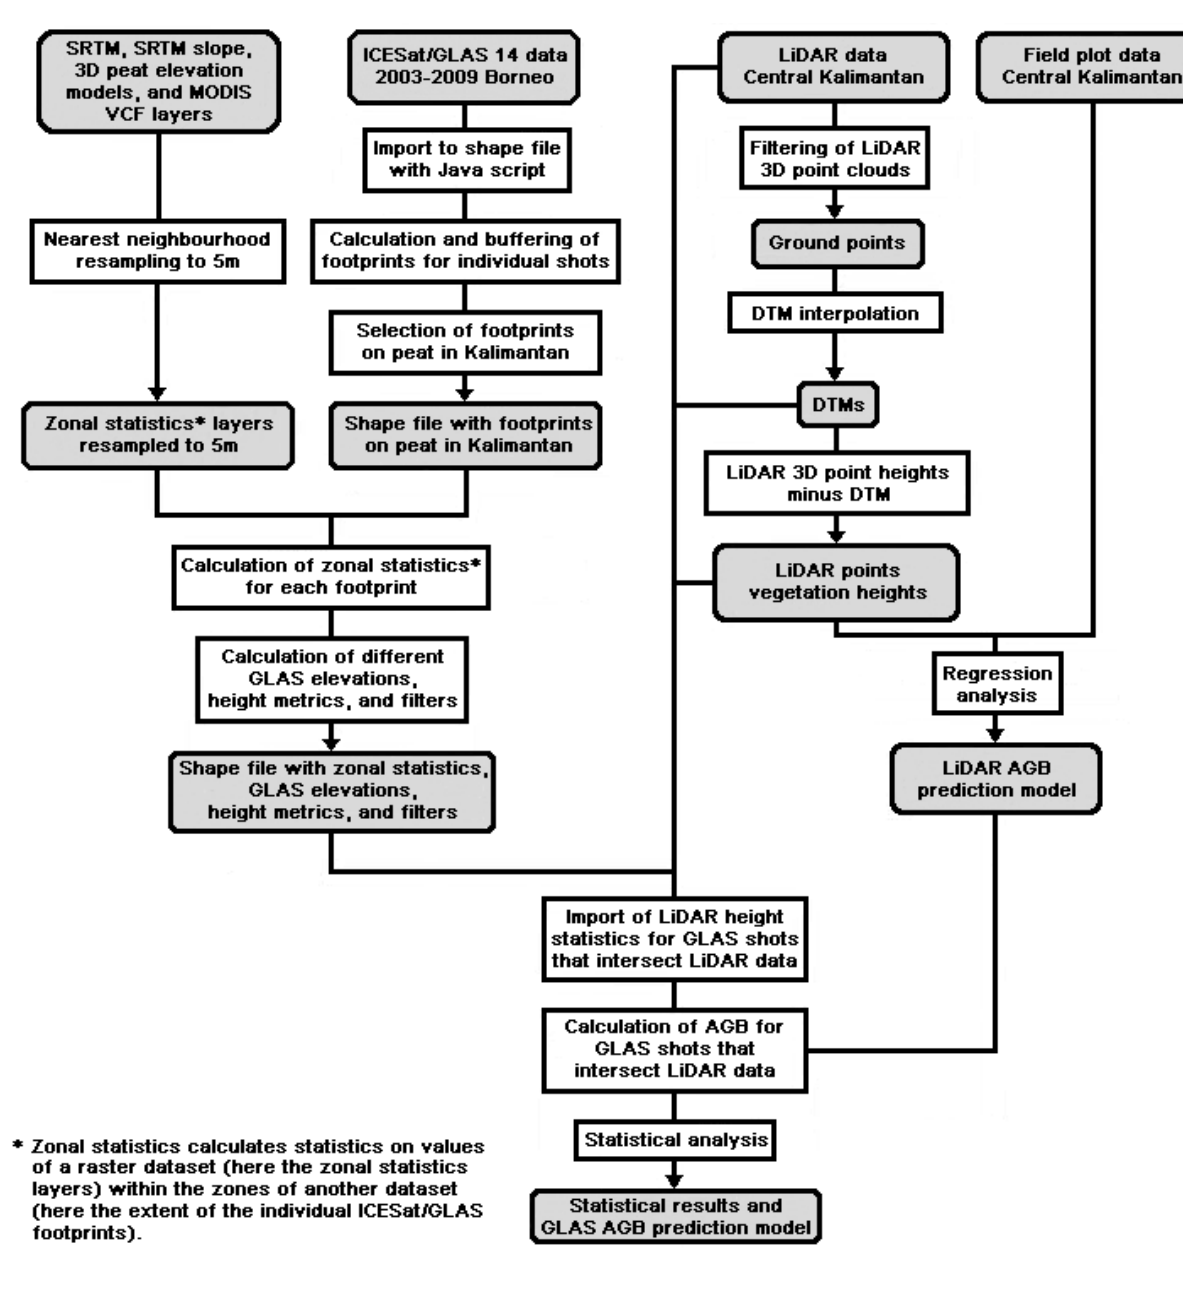
Figure 5. Conceptual overview of the methodology used in this